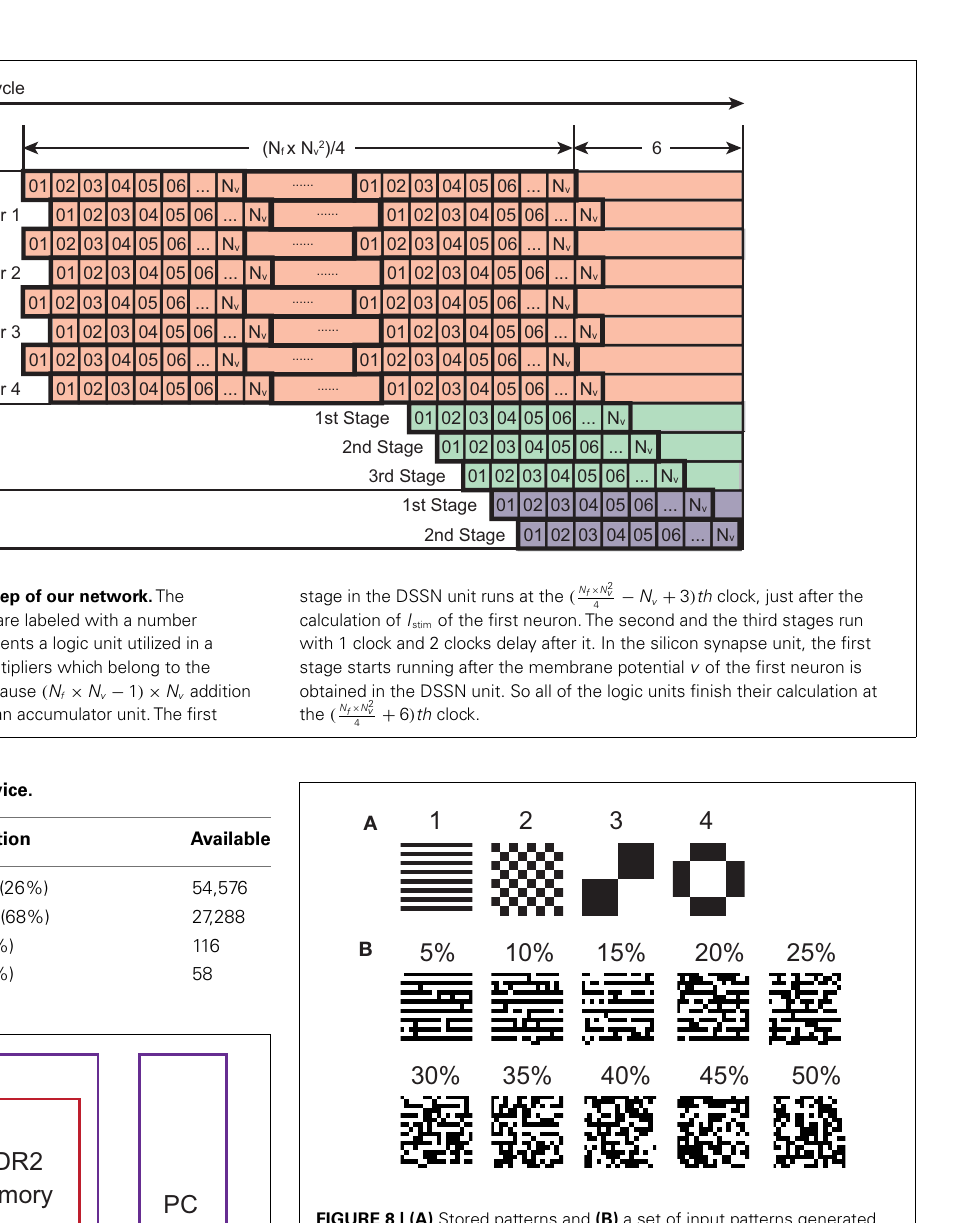
FIGURE 8 | (A) Stored patterns and (B) a set of input patterns generated based on the stored pattern 1.